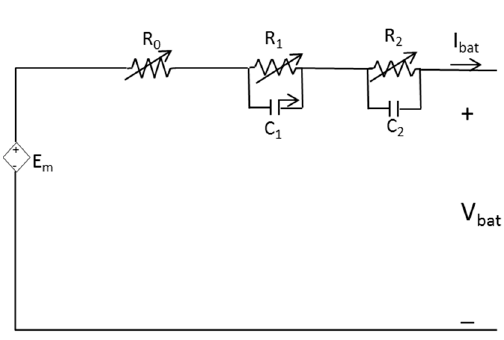
Figure 5. Lithium ‐ ion battery model.